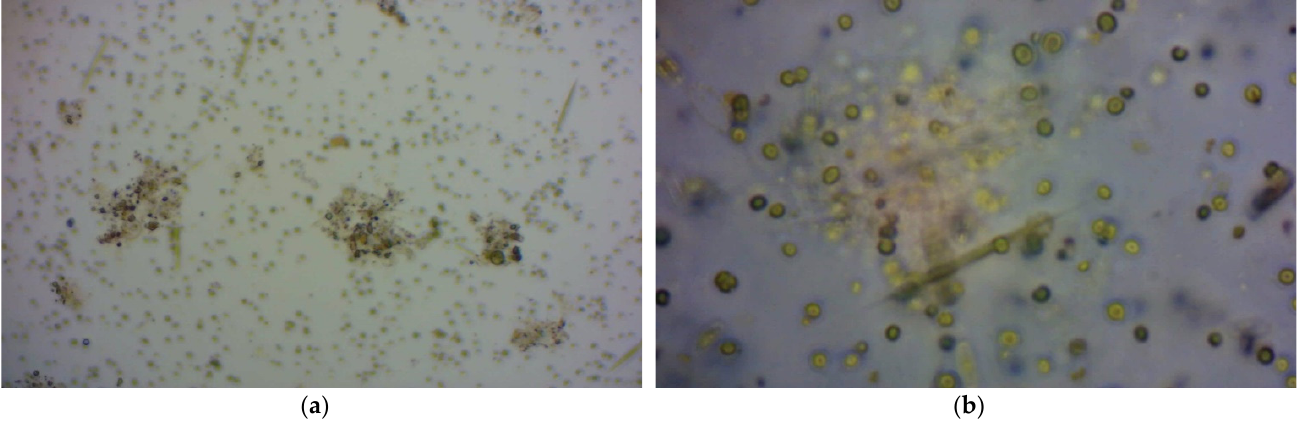
Figure 4. ( a ) Microscope photograph of photobioreactor contents. ( b ) Enlarged microscope photograph of microalgae culture.